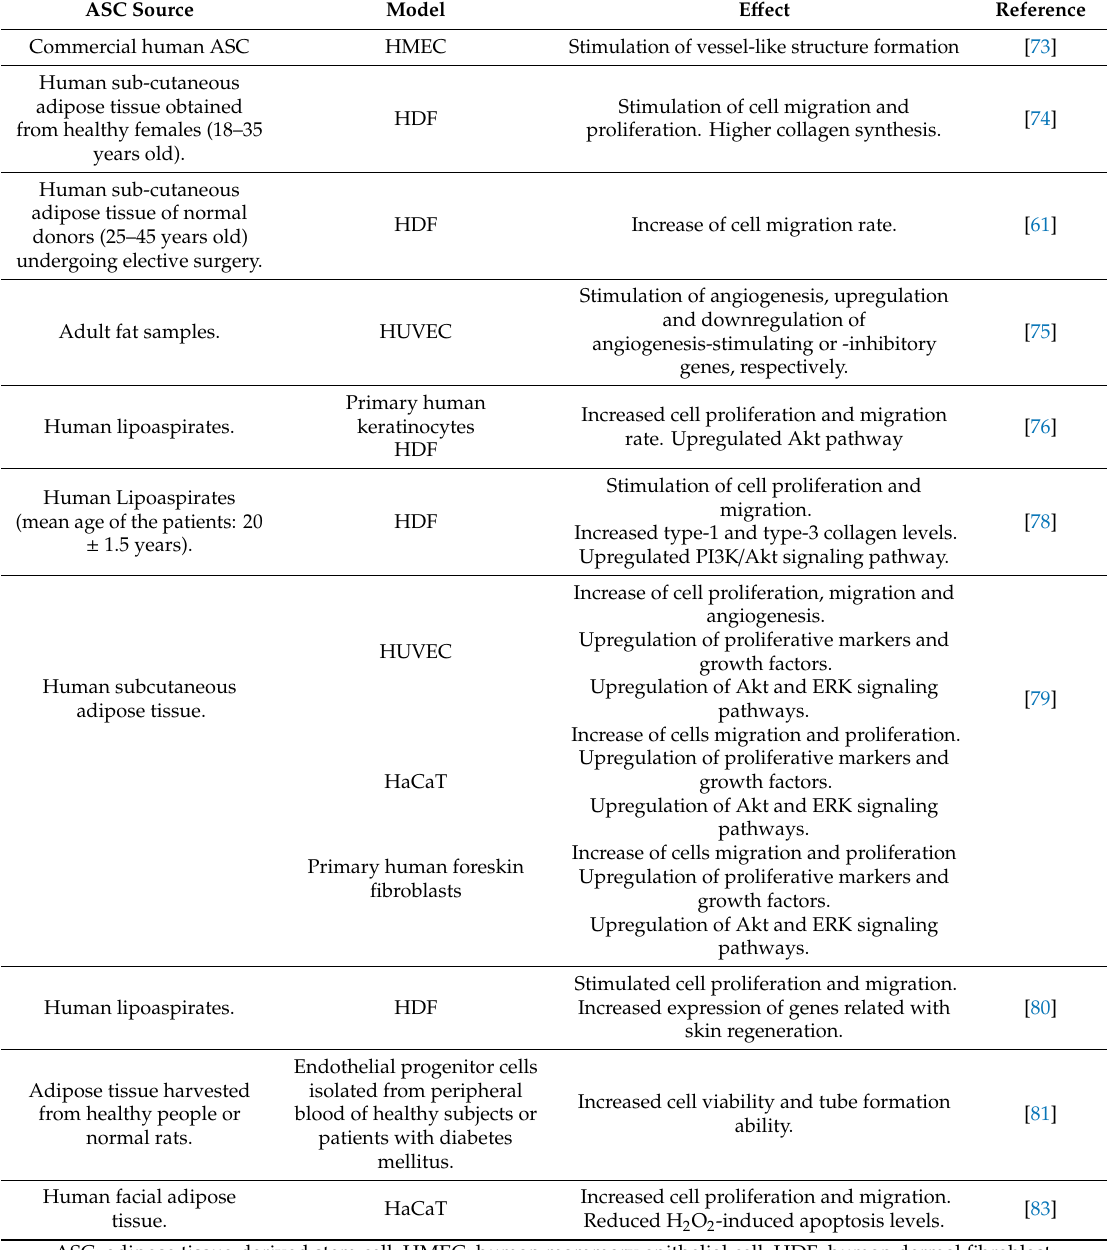
Table 3. E ff ects of ASC-secreted extracellular vesicles on wound healing: In vitro studies. ASC Source Model E ff ect Reference Commercial human